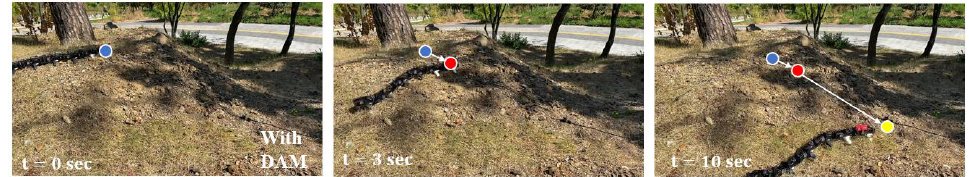
Figure 24. Performance of the descending motion with the DAM on the slope.